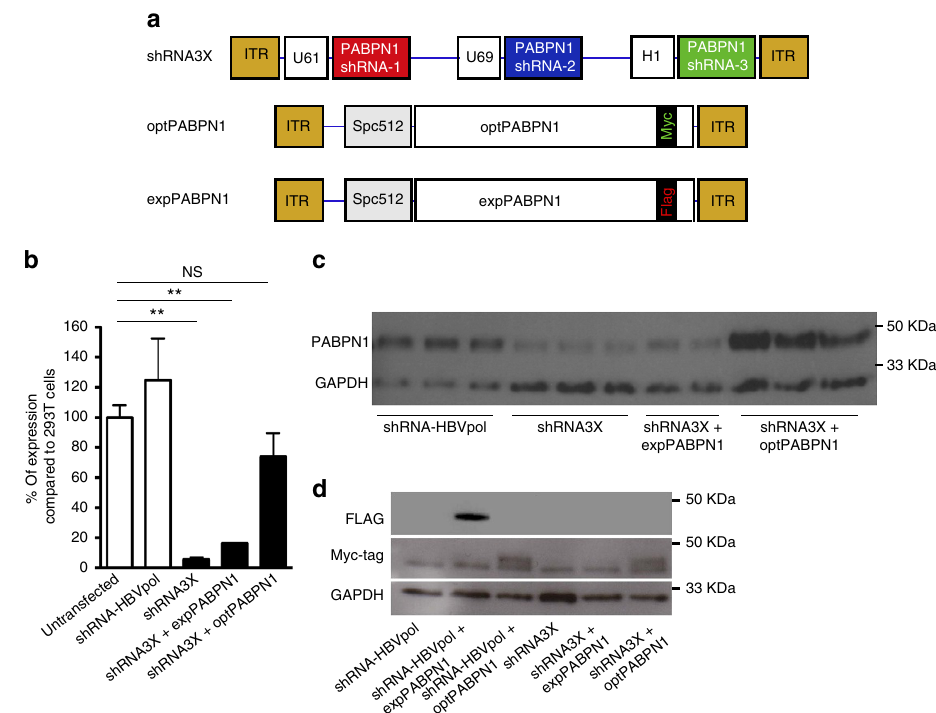
Figure 1 | The tricistronic construct efficiently silences endogenous normal and expanded PABPN1 without affecting optPABPN1 expression in vitro . ( a ) Three constructs were cloned into pAAV vectors and used in this study: a tricistronic shRNA construct including hairpins sh-1, sh-2 and sh-3 driven each by a different polymerase III promoter (U61, U69 and H1, respectively), the sequence-optimized PABPN1 (optPABPN1) driven by the SPc5-12 promoter and tagged with a MYC-tag, and the human expanded PABPN1 (expPABPN1) driven by the SPc5-12 promoter and tagged with a FLAG-tag. ( b ) HEK293T cells were transfected with 4 m g per well of pAAV-shRNA3X in triplicate with or without AAV plasmids expressing expPABPN1 or optPABPN1. Untransfected cells and cells transfected with AAV plasmid expressing shRNA for HBVpol were used as a control. Seventy-two hours post transfection, samples were collected and PABPN1 was detected by western blot and quantified by densitometric analysis using ImageJ software. Transfection was performed twice. PABPN1 expression in each condition was normalized by GAPDH expression level and then by the value of untransfected cells. Transfection with a plasmid expressing shRNA3X induced efficient PABPN1 knockdown even when expPABPN1 was co-expressed compared to untransfected cells. The co-expression with optPABPN1 restored PABPN1 expression to the normal level. ( c ) Representative image of a western blot used for these analyses. ( d ) FLAG is not detected when samples are transfected with shRNA3X. However, in samples prepared from cells transfected with pAAV-opPABPN1, MYC-Tag is detected by western blot. Detection of MYC-Tag shows that optPABPN1 is resistant to degradation by shRNA3X in vitro . Data are presented as mean ± s.e.m., n ¼ 4 (shRNA3X þ optPABPN1) or n ¼ 6 (all the other groups). One-way ANOVA test with Bonferroni post-hoc